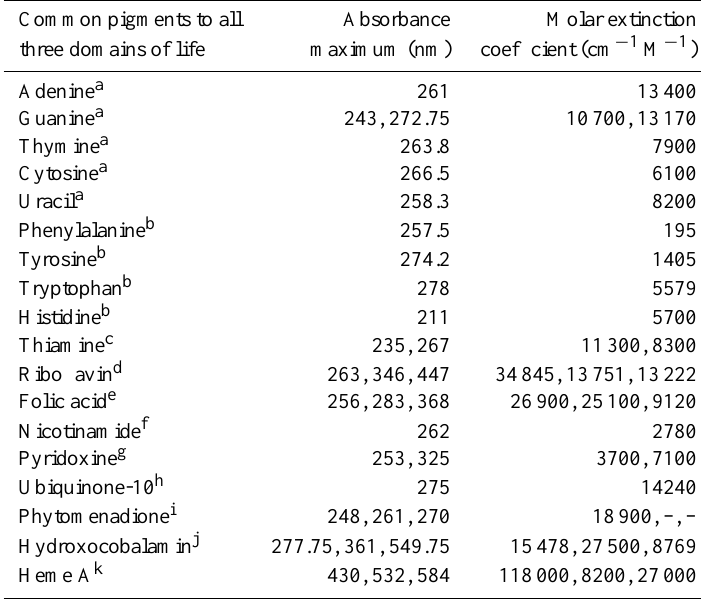
Table 1. Molar extinction coefficients at maximum absorption of the nucleobases, aromatic amino acids, and organic heterocyclic and aromatic cofactors common to all three domains of